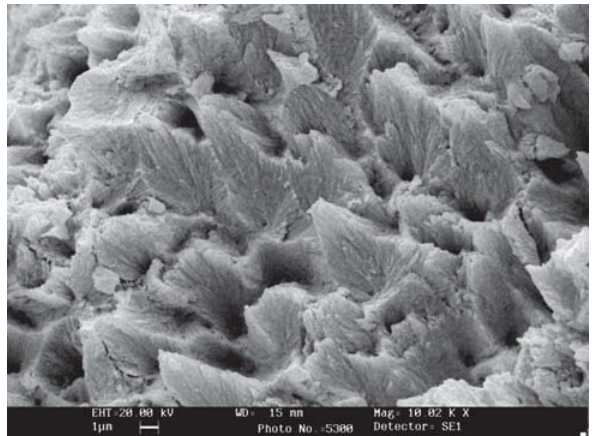
FIGURE 5- Fractured enamel surface of bleached specimens with 10% carbamide peroxide containing 0.05% calcium stored in relative humidity. The general appearance was that enamel seemed more porous than the unbleached specimens, but less than those bleached with only 10% carbamide peroxide